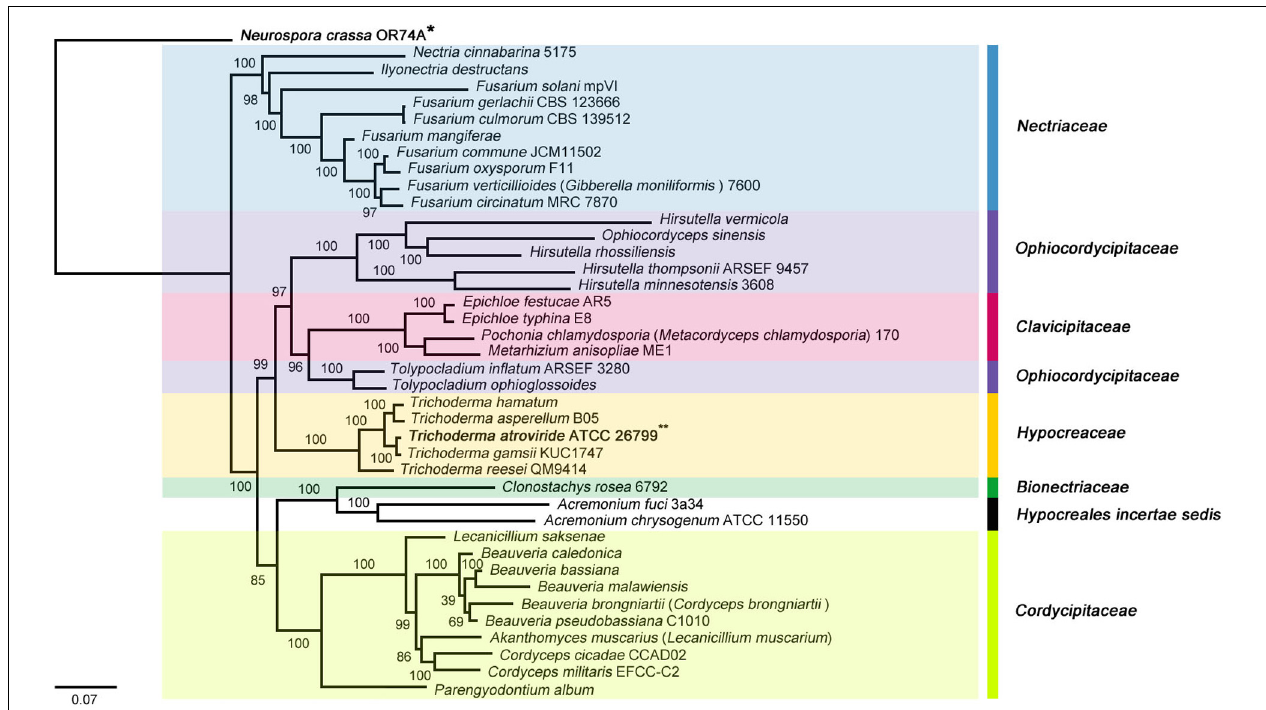
FIGURE 2 | Phylogenetic tree of the Hypocreales species (Sordariomycetes) mitochondrial genomes based on ML (maximum likelihood) analysis. The tree was generated using concatenated sequences of 13 core genes ( atp6, atp8, cob, cox1 , cox2 , cox3 , nad1 , nad2 , nad3 , nad4 , nad4L , nad5 , and nad6 ), and the mitochondrial genome of Neurospora crassa OR74A (Sordariales) was used as an outgroup. All Sordariomycetes species that used for the phylogenetic tree were described in Supplementary Table S4 , and ML bootstrap (BS) values were marked on the